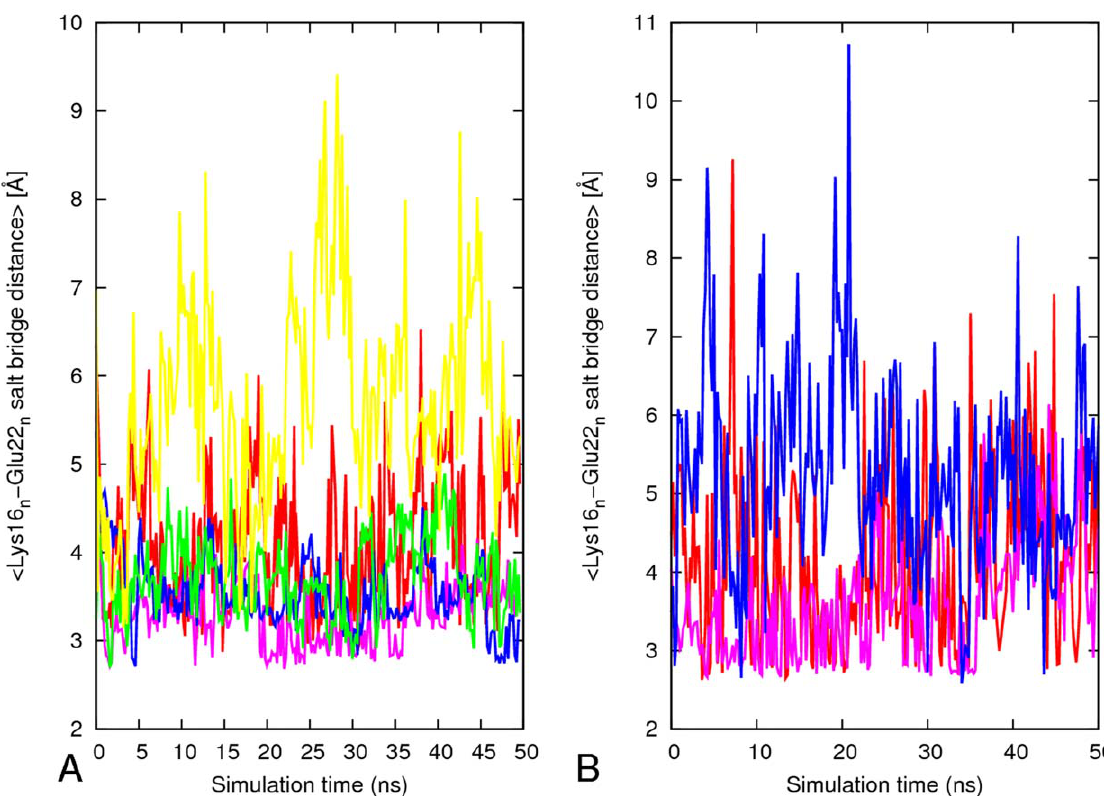
Figure 8. Average inter-sheets salt–bridge distance (Lys n16 /Glu n22 ) along simulation for 16–21P and 16–21AP. A) 16–21P and (B) 16– 21AP. The results are the average of two independent simulation of each system. Red, 1 K 16 - 1 E 22 ; pink, 2 K 16 - 2 E 22 ; blue, 3 K 16 - 3 E 22 ; green , 4 K 16 - 4 E 22 ; yellow, 5 K 16 - 5 E 22 . Red, 16–21P; green, 16–21AP; blue, 27–32; pink, 35–42; cyano, 30–42.